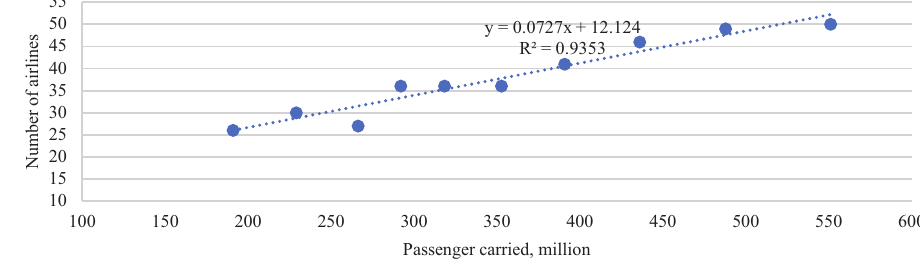
Figure 5. Regression result of passenger carried in China from 2008 to 2017